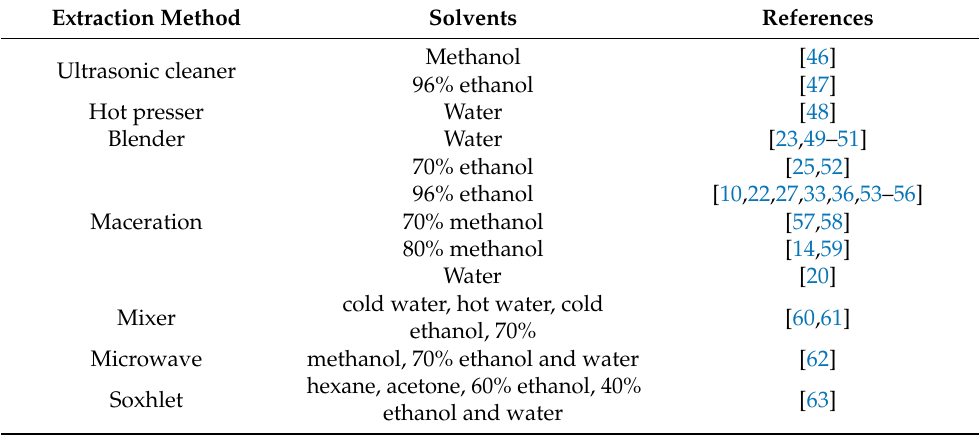
Table 1. The extraction method for papaya leaves along with the solvents